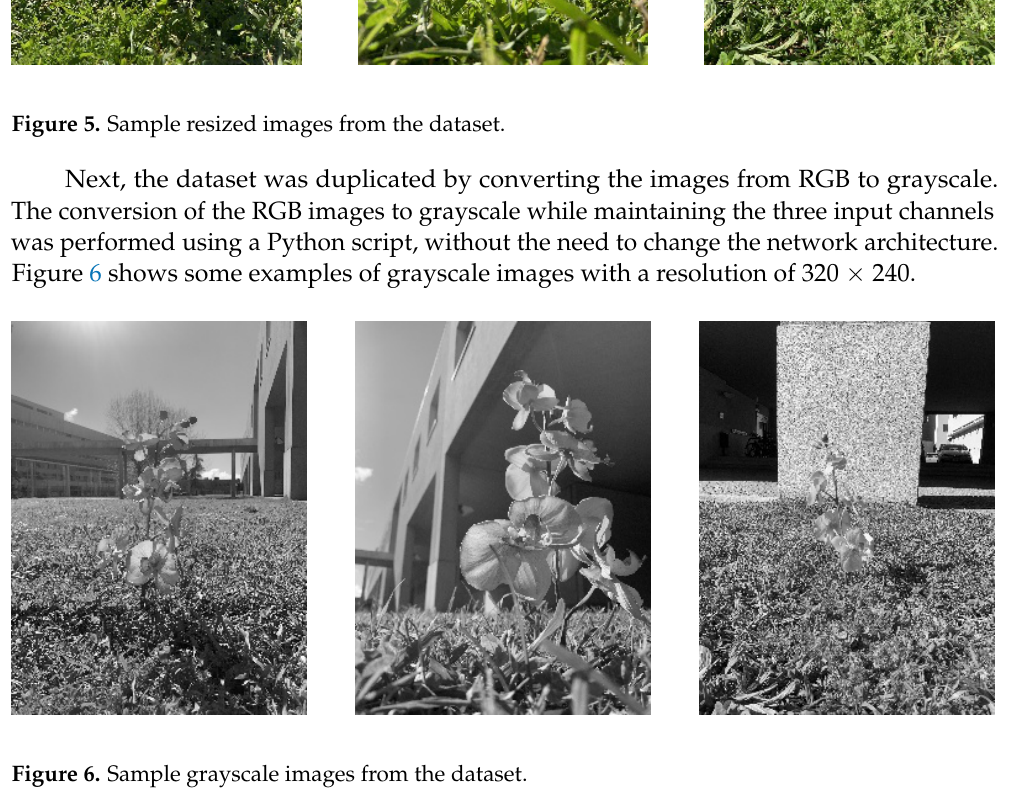
Figure 6. Sample grayscale images from the dataset.